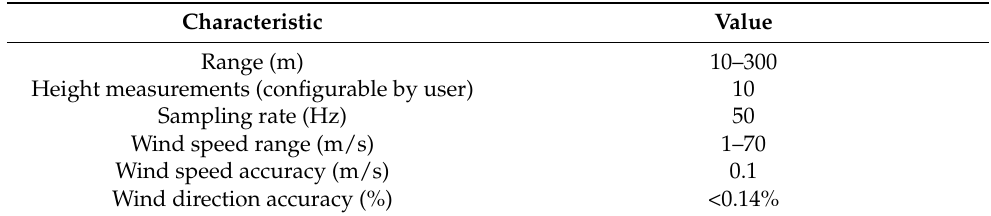
Table 1. Main LiDAR characteristics according to the manufacturer. The accuracy is measured and calculated against a calibrated moving